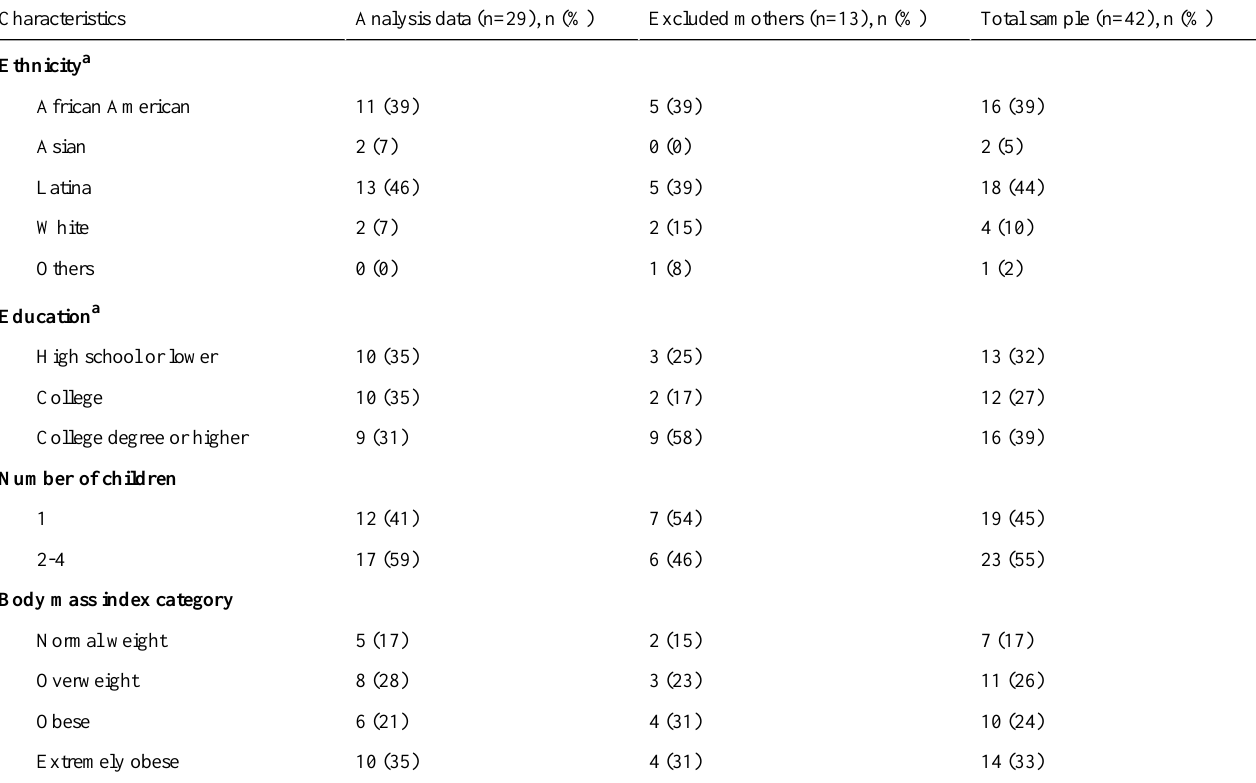
Table 2. Demographic and baseline biomarker characteristics of mothers who were included and those excluded from the analyses due to low ecological momentary assessments completion rates.